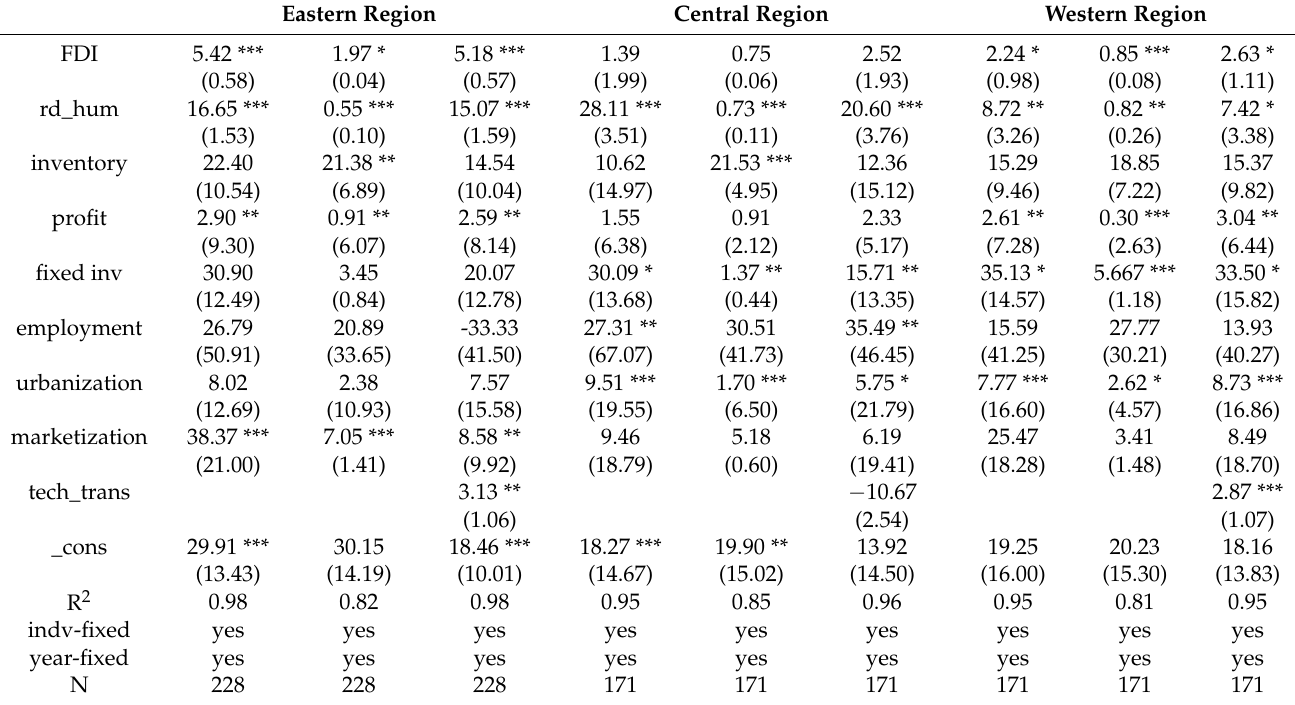
Table 6. Heterogeneity analysis on the main effect and mediating effect.